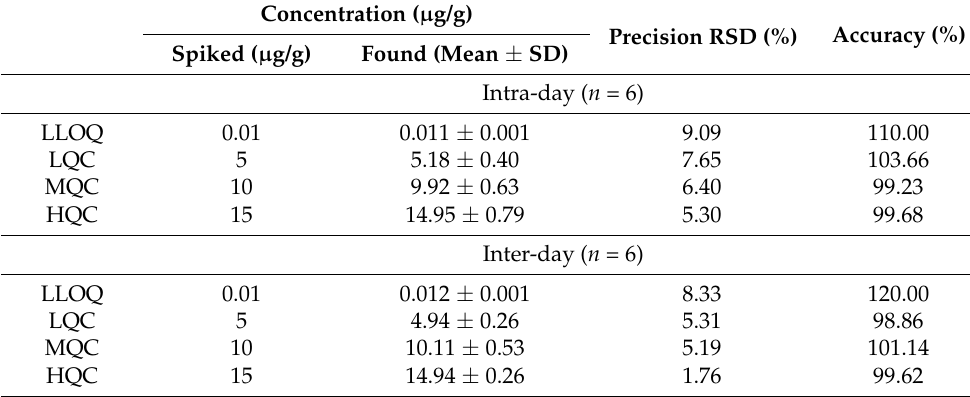
Table 3. Intra-day and inter-day precision and accuracy for the quantification of DOX in rat liver tissue samples via the developed SPE-LC-FL method ( n = 6).